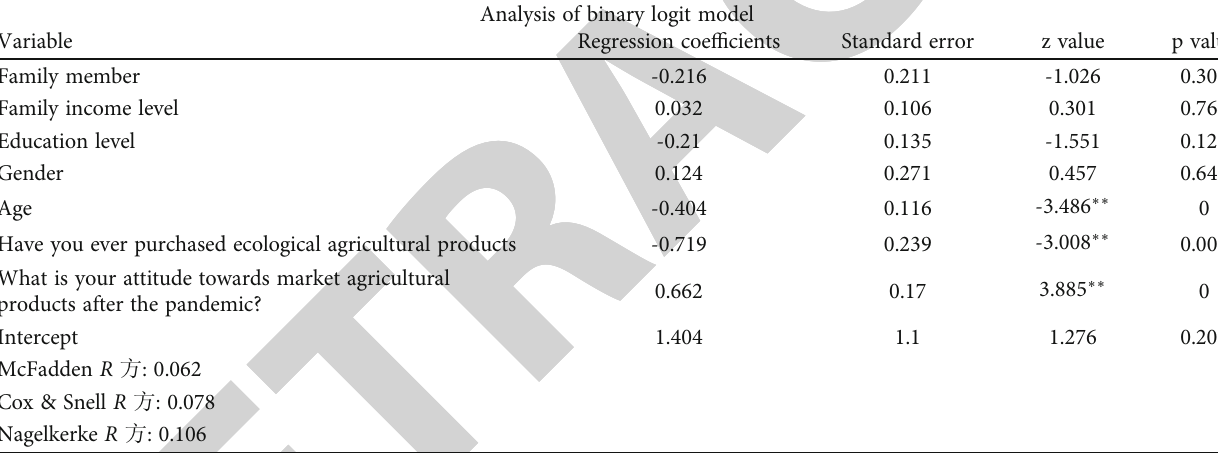
Table 6: Model analysis of factors a ff ecting consumer choice